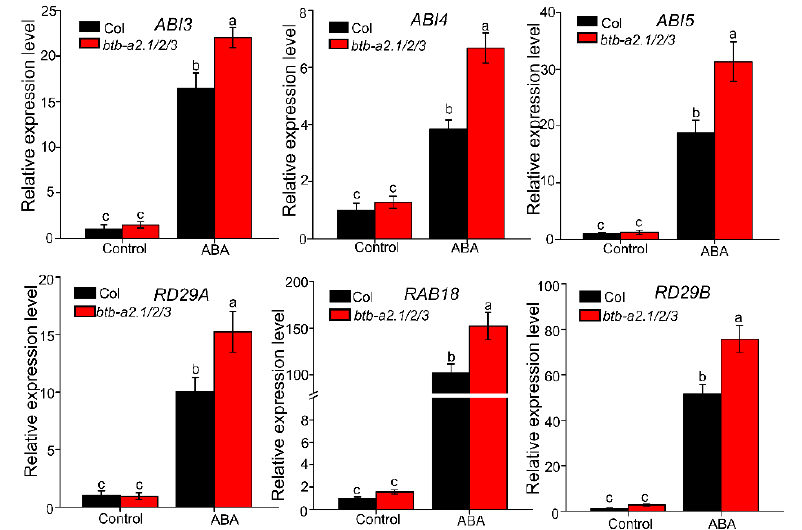
Figure 4. Expression analysis of ABA signaling-related genes. Total RNA was isolated from 7-day-old WT and btb-a2.1/2/3 seedlings growing under normal and 0.5 μM ABA conditions. The ACTIN2 gene was used as an internal reference. Data are the mean ± SD. n = 3. Different letters indicate a significant difference ( p < 0.05).